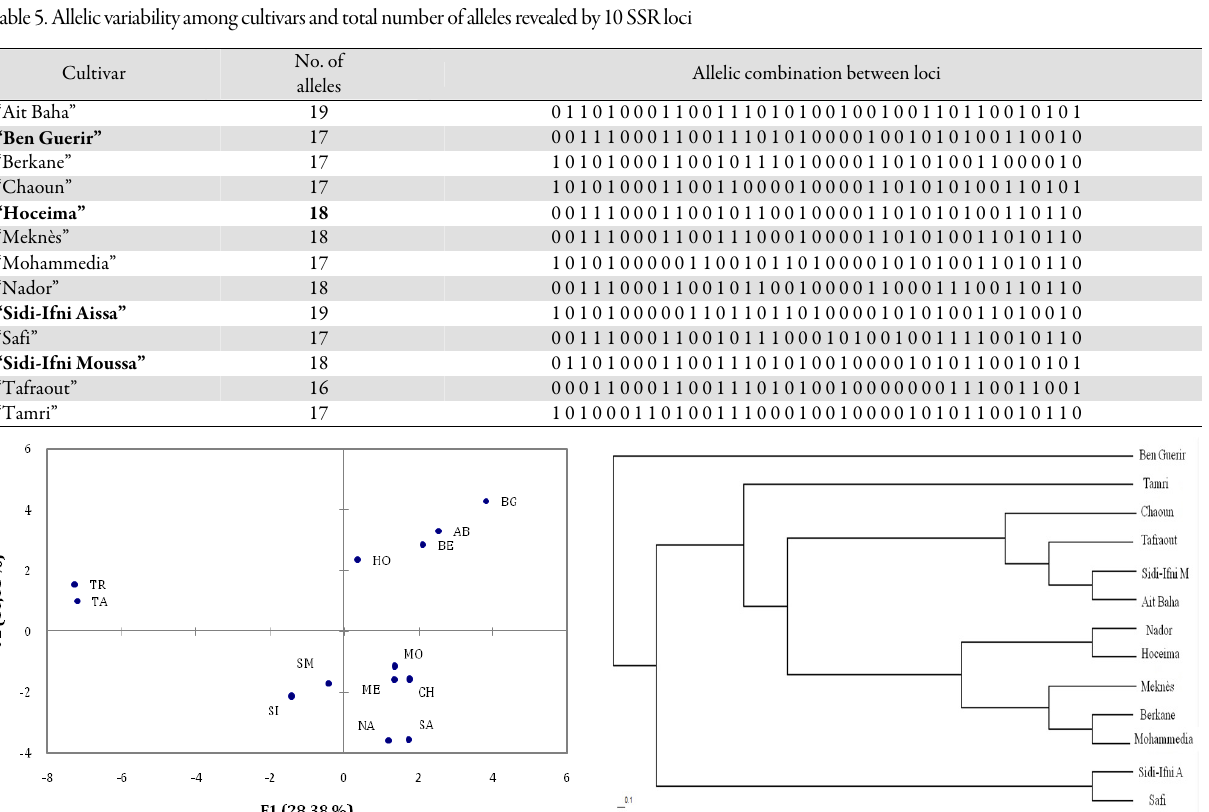
Fig. 3. UPGMA dendrogram of 13 local cactus cultivars based on SSR